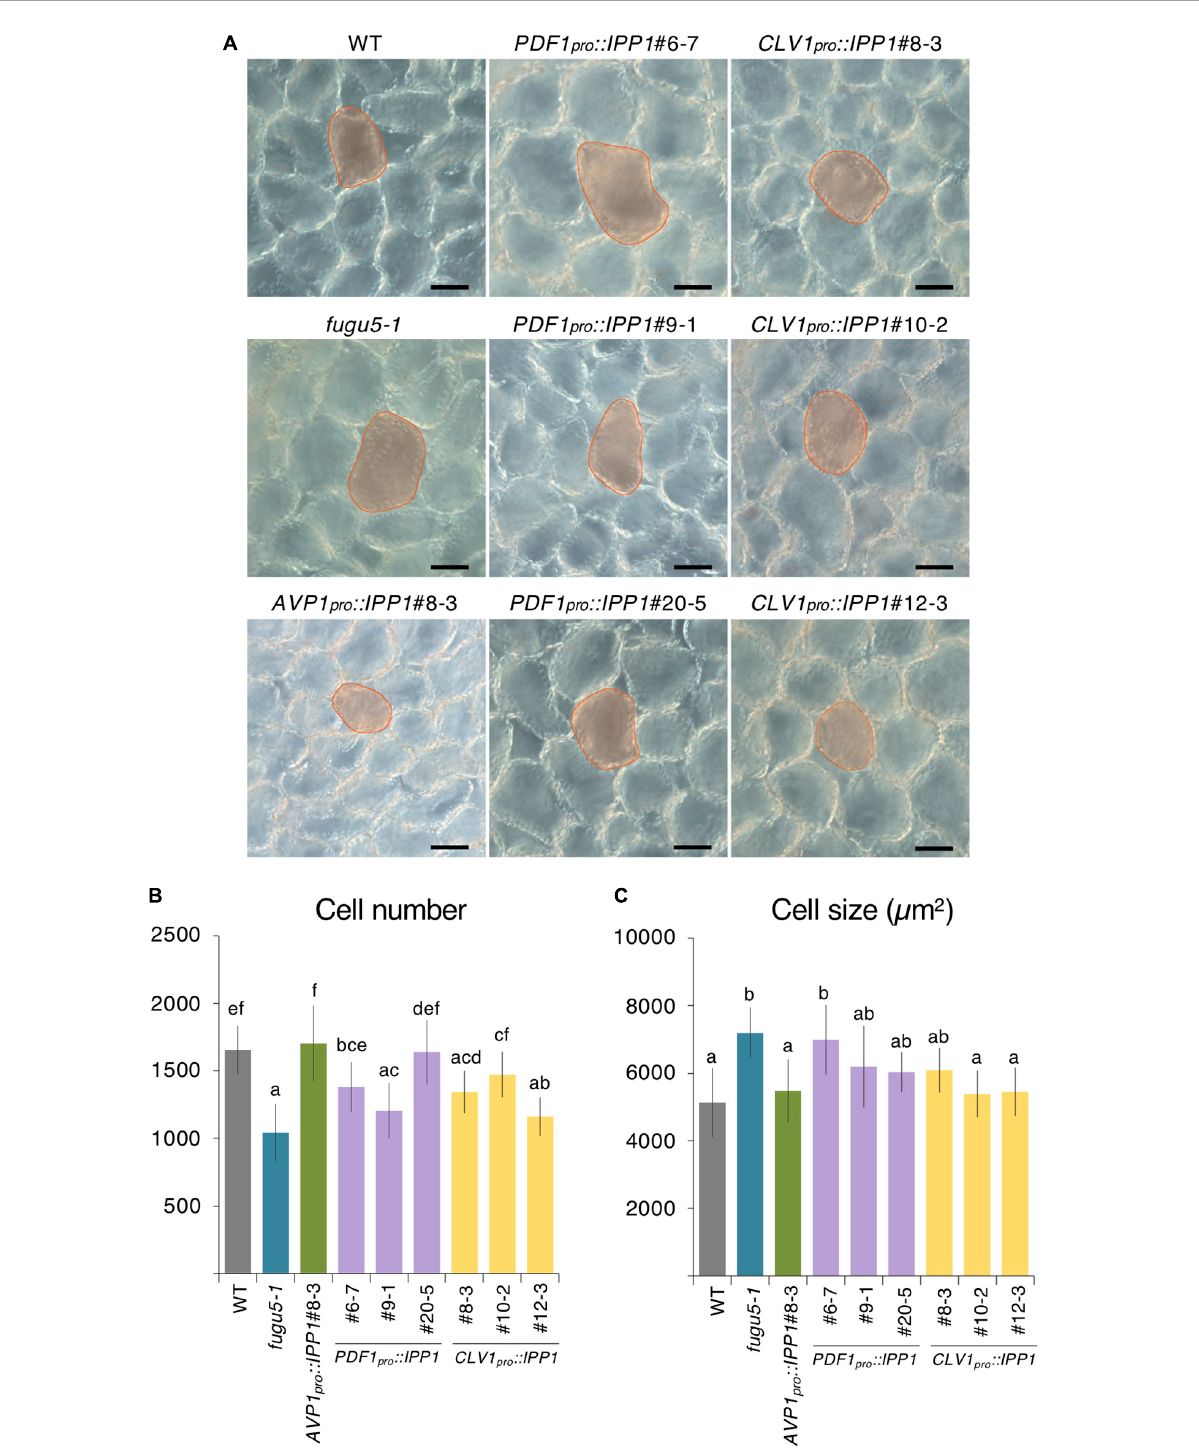
FIGURE2 Palisade cellular phenotypes of mature cotyledons from the PDF1 pro ::IPP1 and CLV1 pro ::IPP1 transgenic lines. (A) Micrographs of palisade tissue cells from cleared cotyledons of the wildtype (WT), fugu5-1 , AVP1 pro ::IPP1 #8-3, PDF1 pro ::IPP1 #6-7, PDF1 pro ::IPP1 #9-1, PDF1 pro ::IPP1 #20-5, CLV1 pro ::IPP1 #8-3, CLV1 pro ::IPP1 #10-2, and CLV1 pro ::IPP1 #12-3 lines at 25 DAS. Red contour and shadow highlight representative cell size in each genotype. Scale bar = 50 µ m. (B,C) Numbers of subepidermal palisade tissue cells (B) and their average sizes (C) . Data are means ± SD ( n ≥ 9 cotyledons). Each character represents a significant difference at p < 0.05 (Tukey’s HSD test). DAS, days after seed